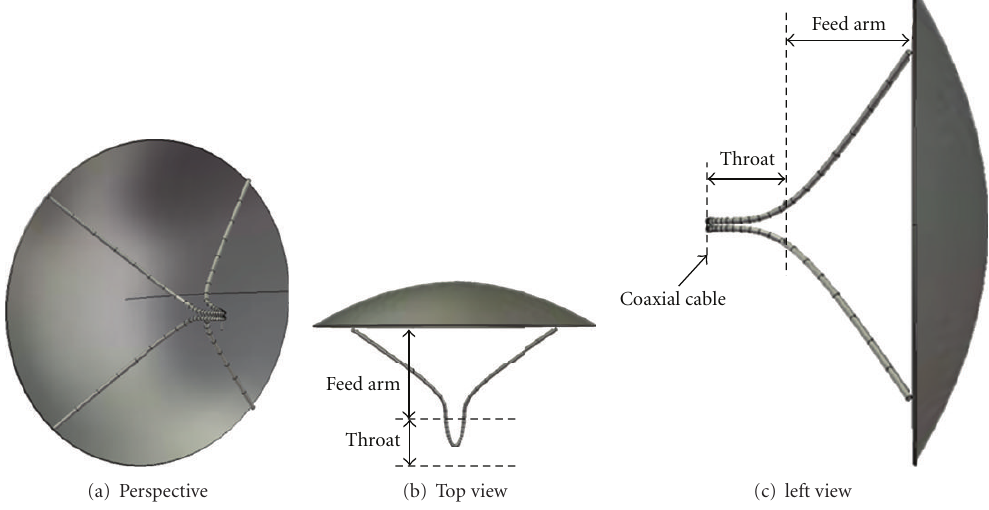
Figure 1: Wire-type feed horn fed parabolic reflector.